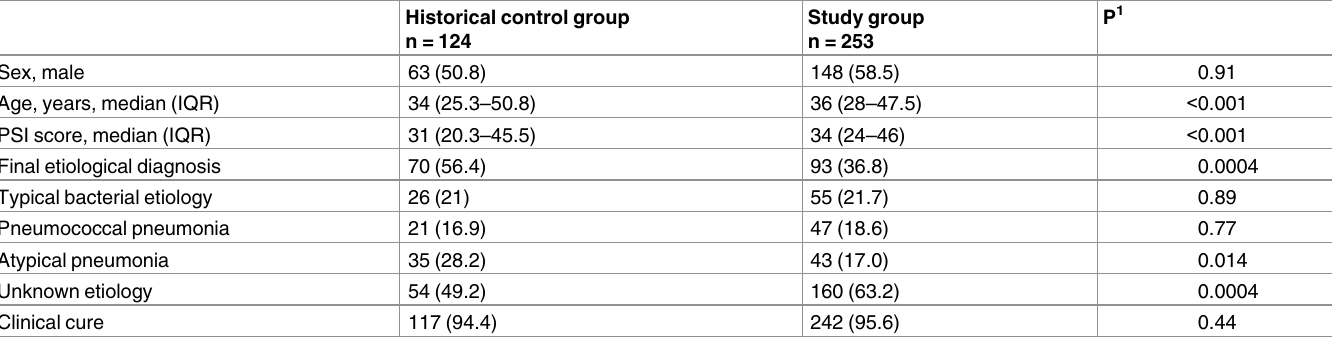
Table 4. Comparison between the historical control and the study